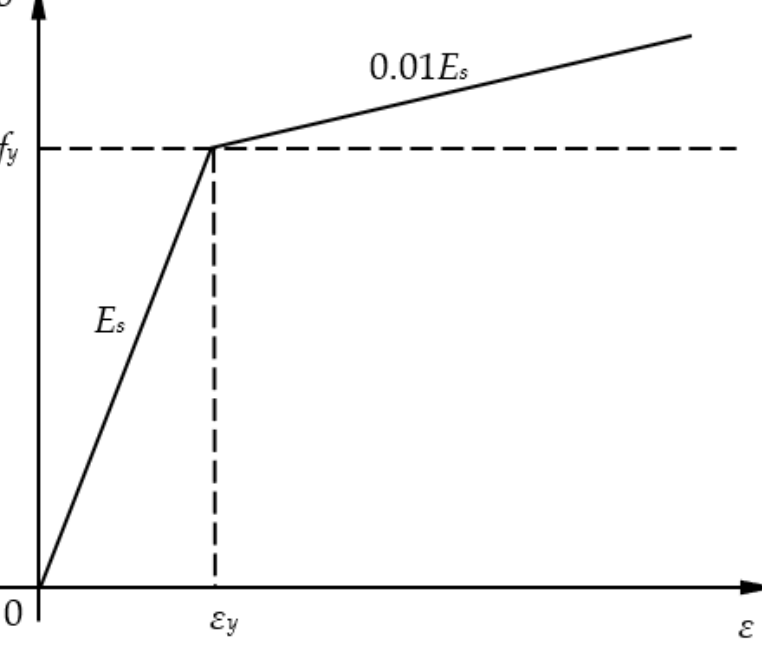
Figure 1. Stress–strain curve of the steel Figure 1. Stress‒strain curve of the steel bars.